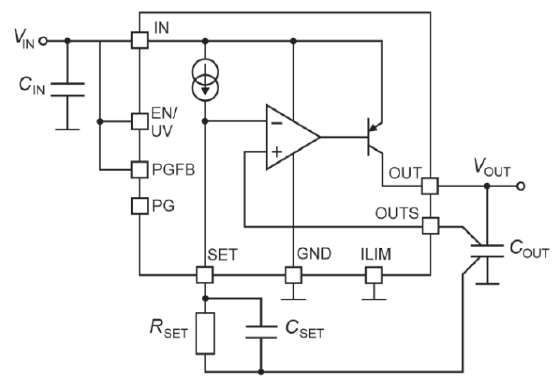
Figure 7. Voltage source with linear regulator LT3045 [40].